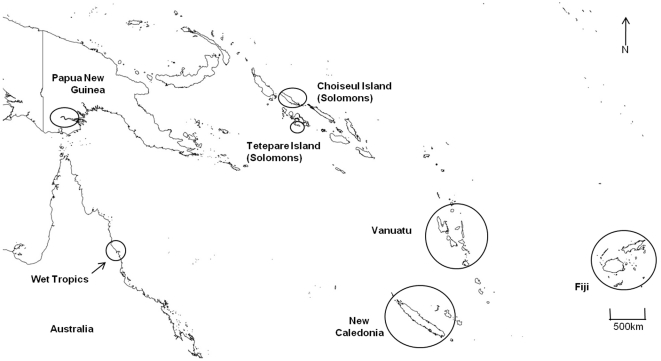
Map of the West Pacific freshwater fish communities used in analyses.Map indicating the Wet Tropics of north-eastern Australia, in relation to Papua New Guinea and West Pacific island groups. Open circles denote regions were freshwater fish communities were included for analyses.